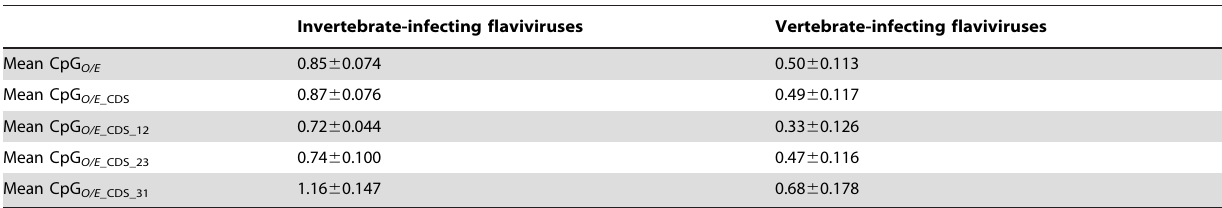
Invertebrate-infecting flaviviruses Vertebrate-infecting